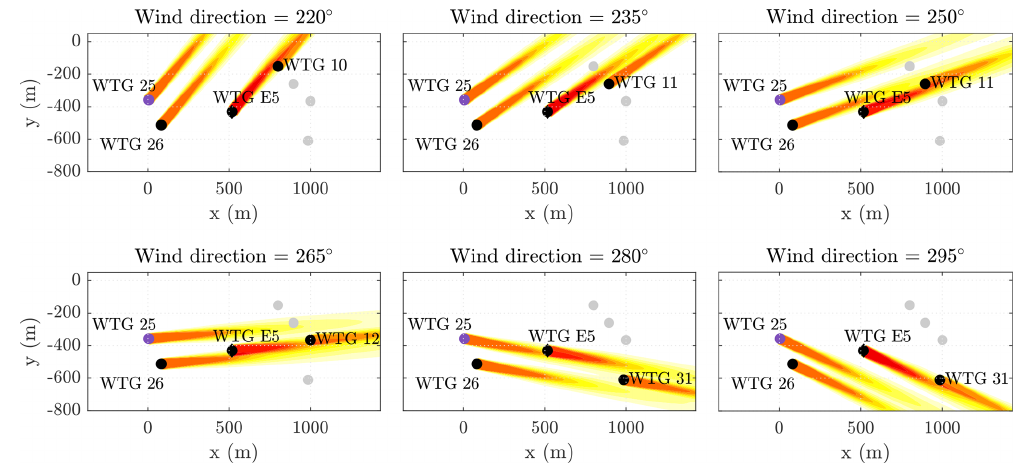
Figure 3. Predicted flow fields for various wind directions in baseline operation. To maximize the benefits of wake steering, only three turbines are considered at a time, depending on the ambient wind direction. The considered turbines are WTG 26, WTG E5, and one of the downstream turbines (operated without yaw misalignment). The schedule of which turbines are considered is listed in Table 2. Note that this figure is shown for explanatory purposes, and therefore the simulation setup is not described in